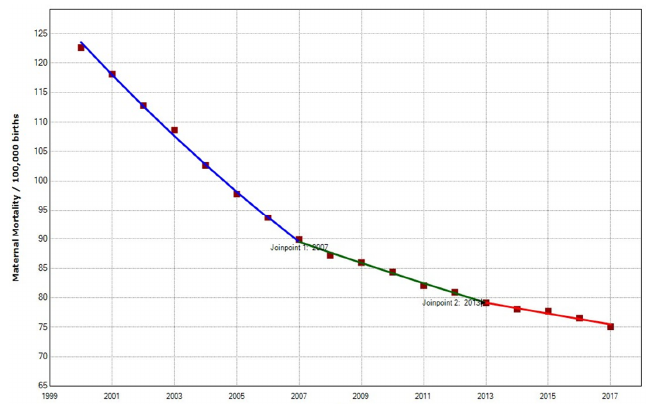
Figure 5. Maternal mortality trends in North Africa (2000–2017) indicate joinpoints at the transitions between colored lines.